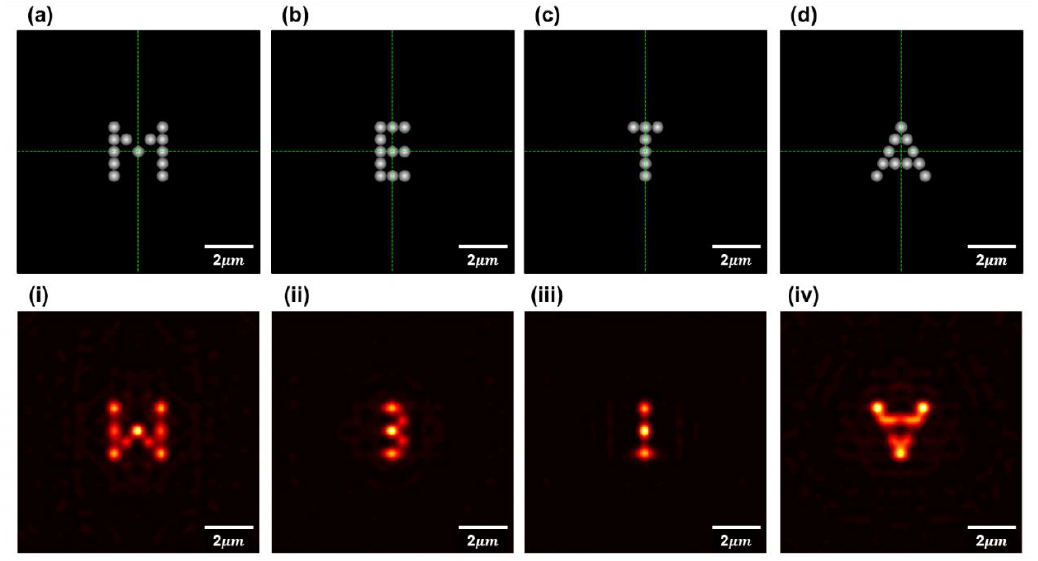
Figure 6. Imaging of designed structures that are composed of multiple incoherent point light sources. Plates ( a ) to ( d ) display the designed structures which are composed of multiple incoherent point light sources of λ = 660 nm as characters of M, E, T and A, respectively. The smallest distance between the point light sources is 500 nm. The designed characters are placed on an object plane at Z obj = 13.5 μm away from a 20-fold symmetry quasi-periodic nanohole array lens and the size of the structures is 2.5 × 2.5 μm 2 whose central point is aligned with the central axis of the array lens. Plates ( i ) to ( iv ) show the corresponding imaged patterns but with a rotation of 180°. All the images are 10 × 10 μm 2